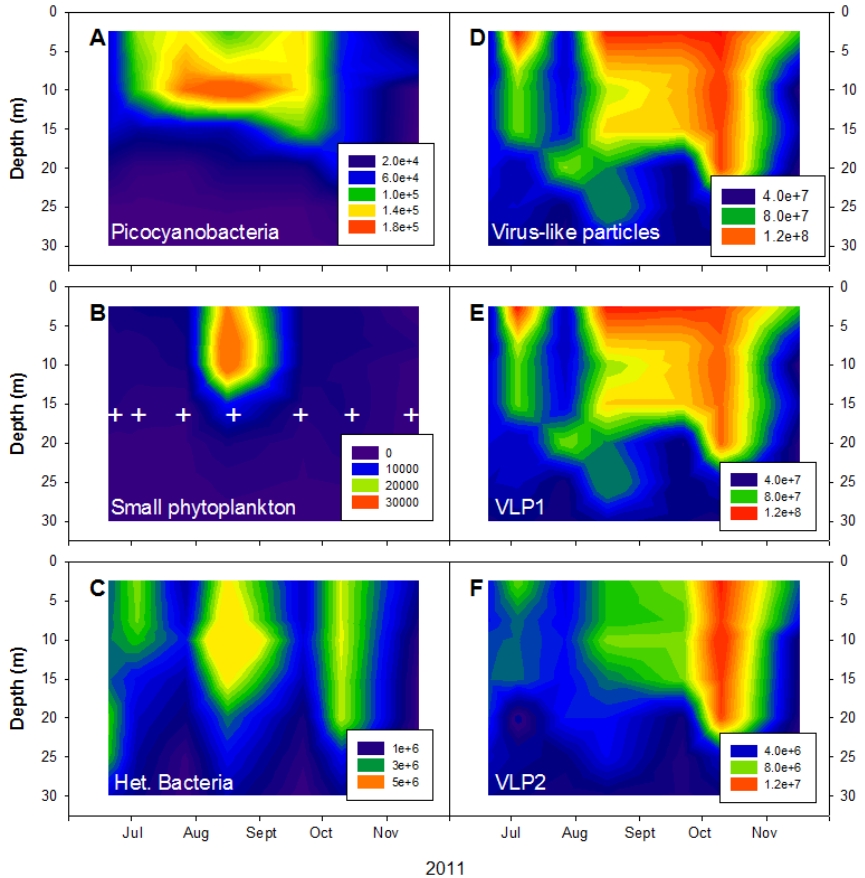
Fig. 2. Vertical distribution of picocyanobacteria (A), small phytoplankton populations (B), heterotrophic bacteria (C), total virus-like particles (D), VLP1 (E) and VLP2 (F) from July to November 2011 using flow cytometry. The white crosses on panel B refer to sampling dates. The interpolation between the data was generated automatically by SigmaPlot 12.0.